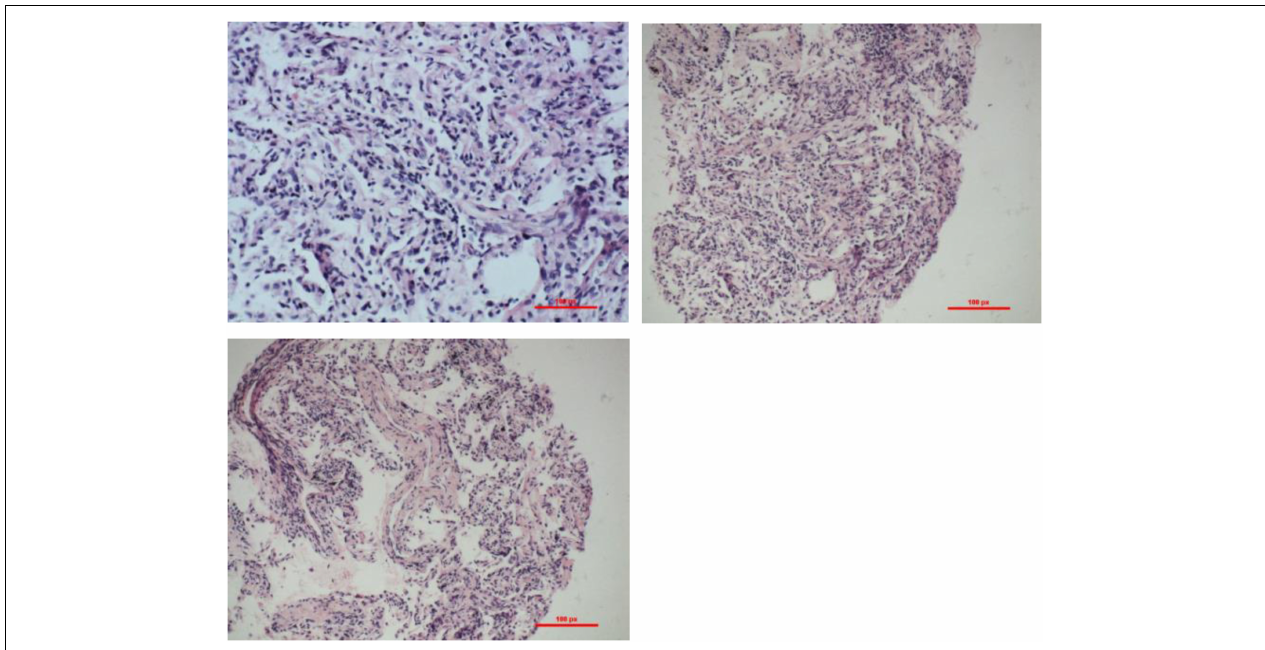
FIGURE 2 | Transbronchial biopsy (TBLB) pathology of the basal segment of the right lower lobe through bronchoscopy: interstitial fibrosis with inflammatory cell infiltration. H&E staining: observed under the light microscope, the alveolar structure was not significantly damaged, alveolar type II epithelial hyperplasia, widening of alveolar space, accompanied by the proliferation of histiocytes and fibroblasts, and infiltrating lymphocytes between the alveolar cavity and small blood